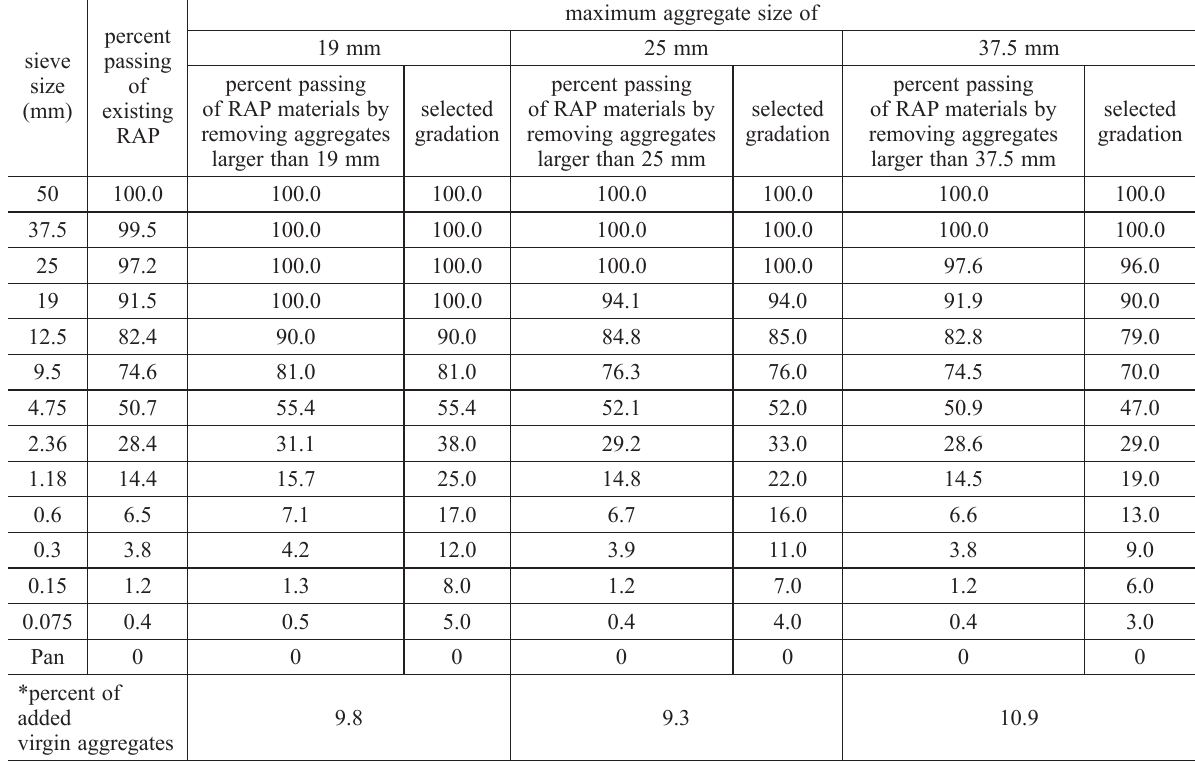
Table 1. Detailed proportions of three RAP gradations